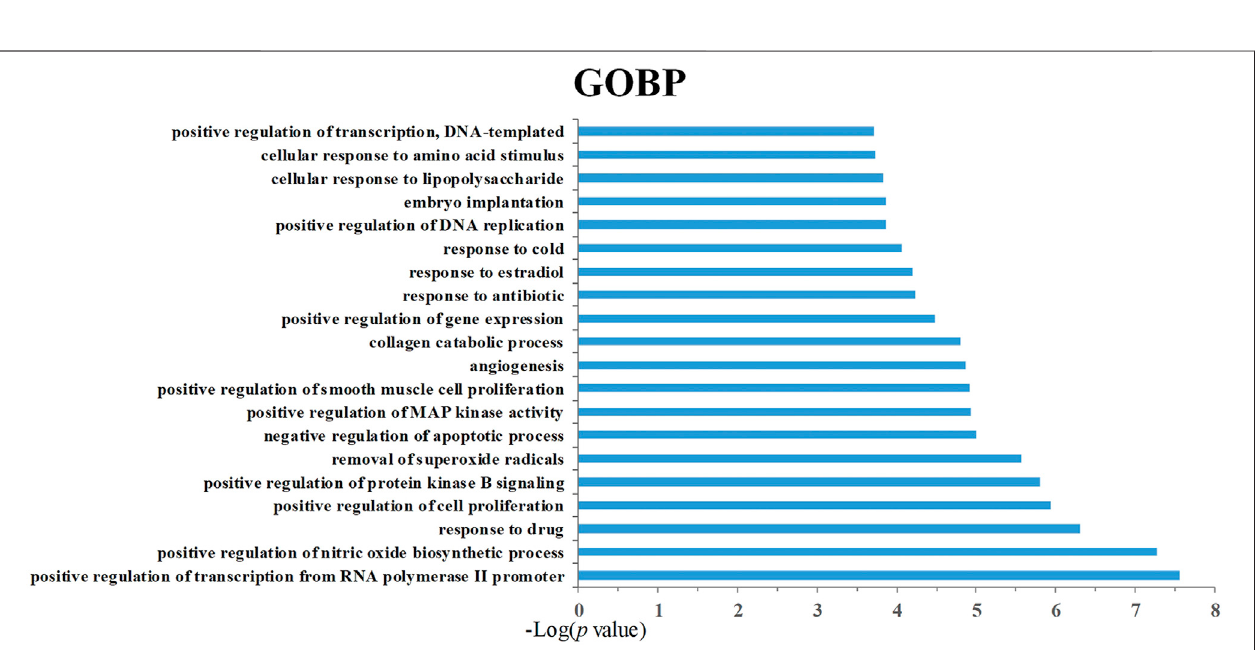
FIGURE 5 | Gene Ontology biological process (GOBP) analysis of target genes. The y-axis shows signi fi cantly enriched “ biological process ” (BP) categories in GO relative to the target genes, and the x-axis shows the enrichment scores of these terms ( p -value ≤ 0.05).